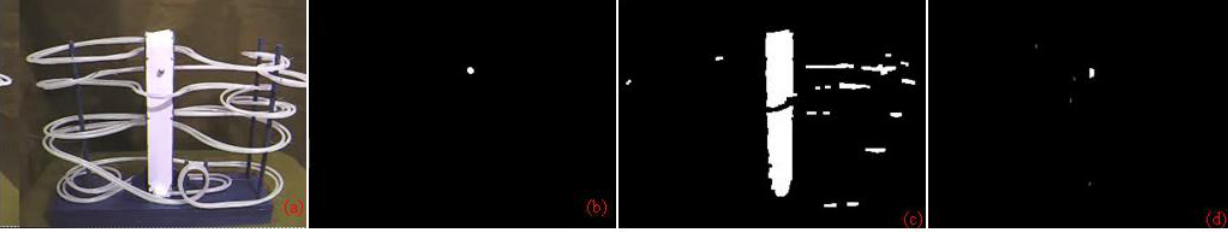
Table 5. Performance comparison between Renno et al . method and Zulkifley et al . algorithm. Method TER TPR FPR Renno et al . 5 : 055% 0 : 891